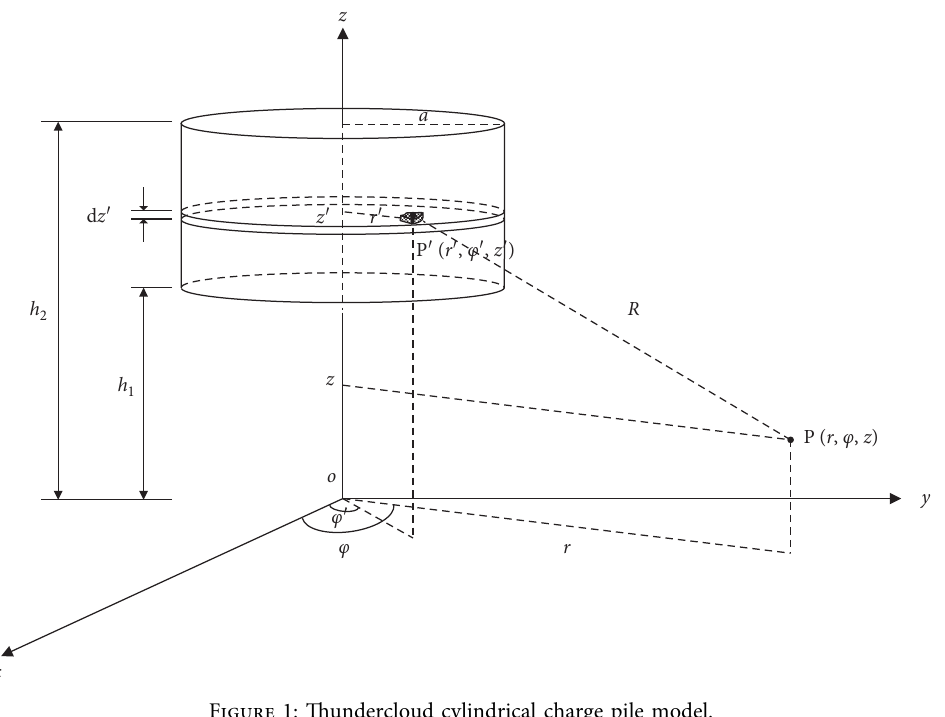
Figure 1: Thundercloud cylindrical charge pile